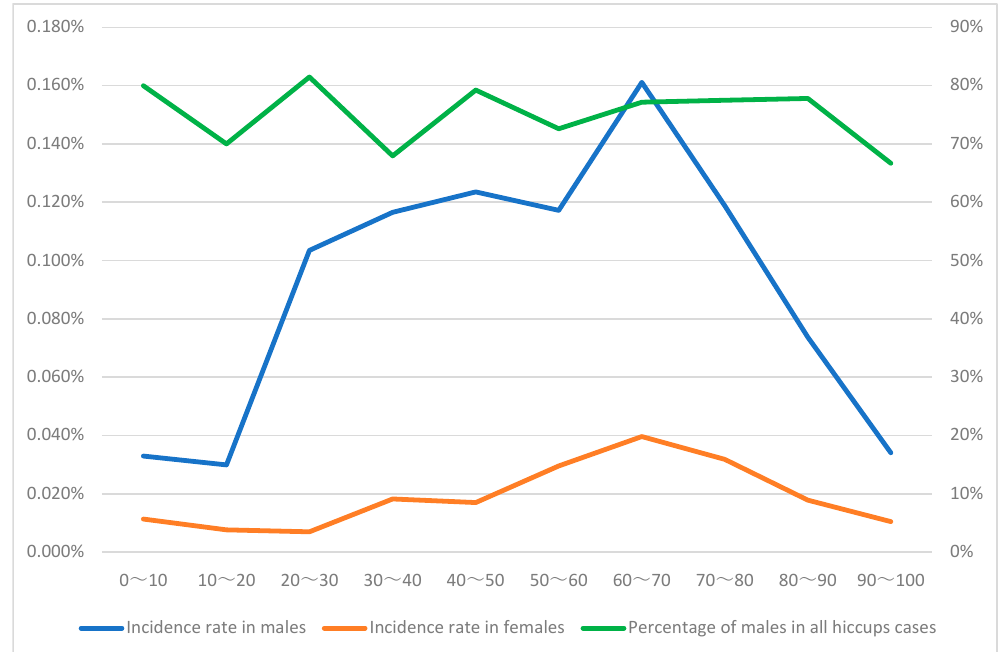
Figure 2. Male and female incidence rates and the percentage of males in cases of hiccups. The graph shows the age on the horizontal axis and the incidence rate (%) on the left vertical axis. The percentage of males in all hiccup cases is shown on the right vertical axis.